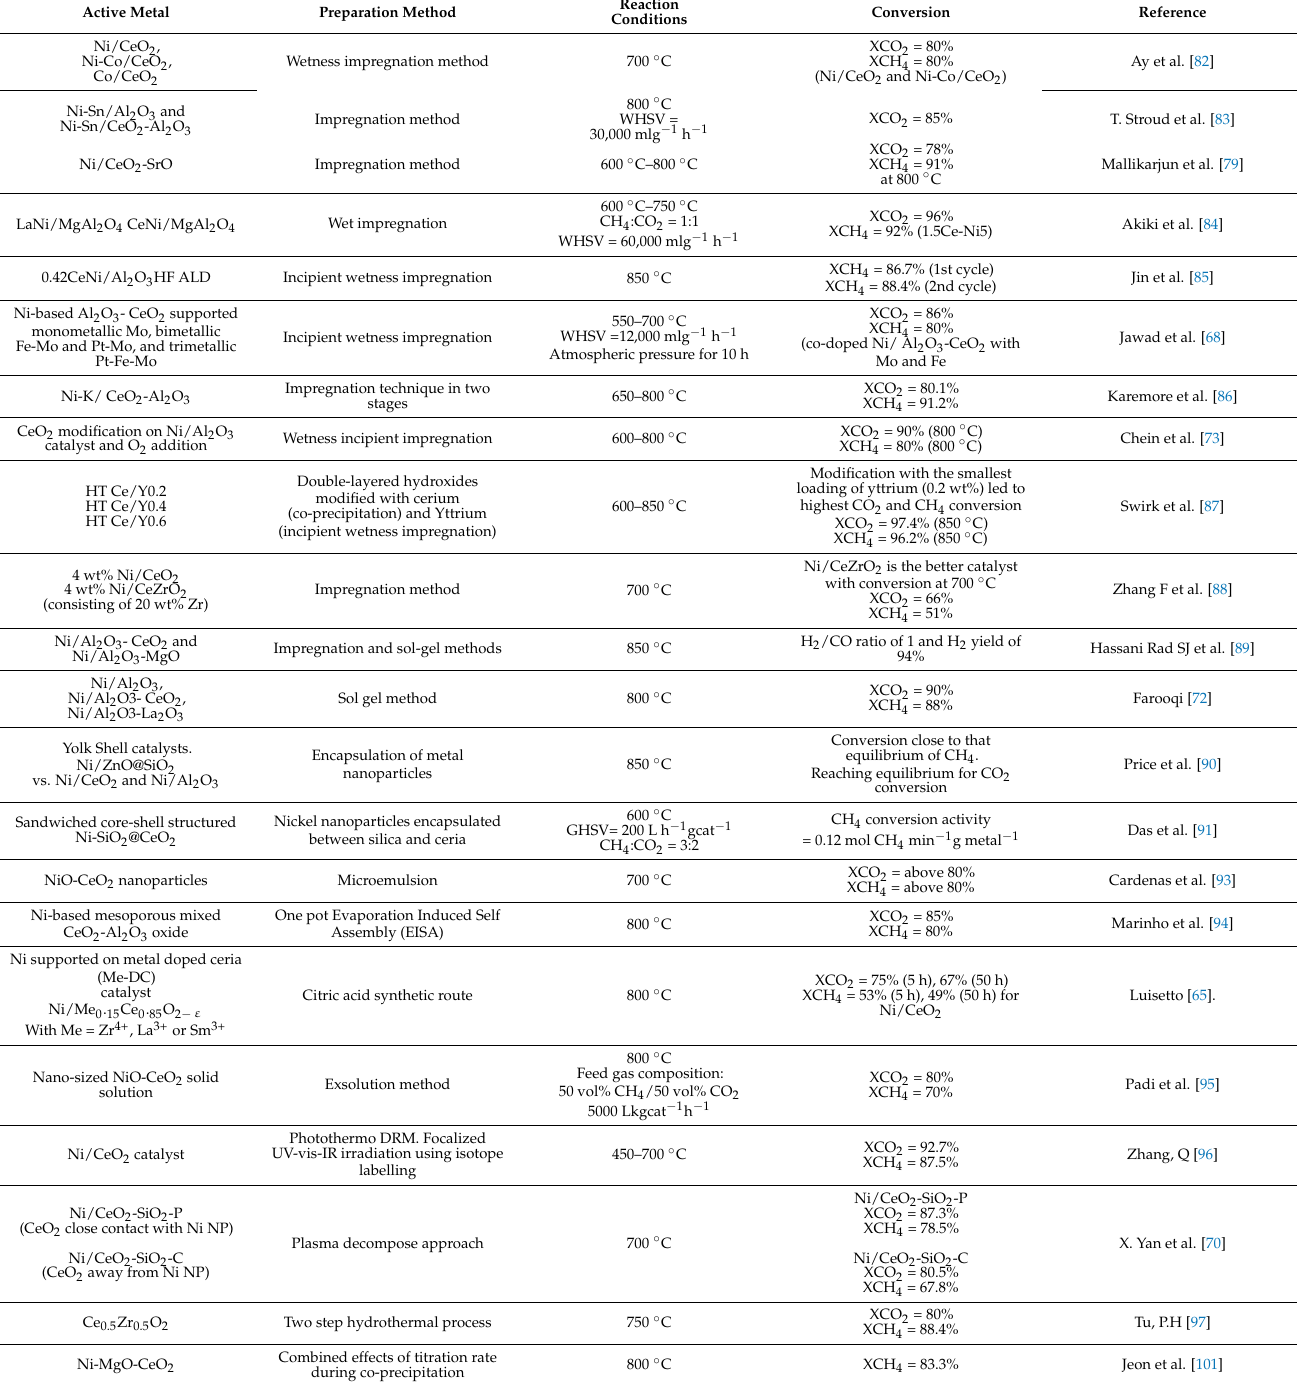
Table 1. Summary of DRM with CeO 2 -based catalysts from 2015 to